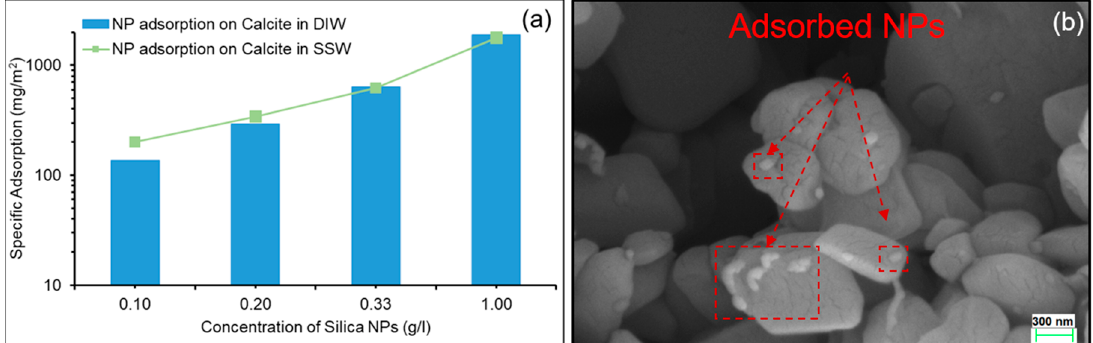
Figure 3. ( a ) Adsorption of silica NPs on Calcite surface. ( b ) SEM image of NPs adsorbed on chalk core with DP 9711 nanofluid at 1 g/L concentration prepared in DIW.